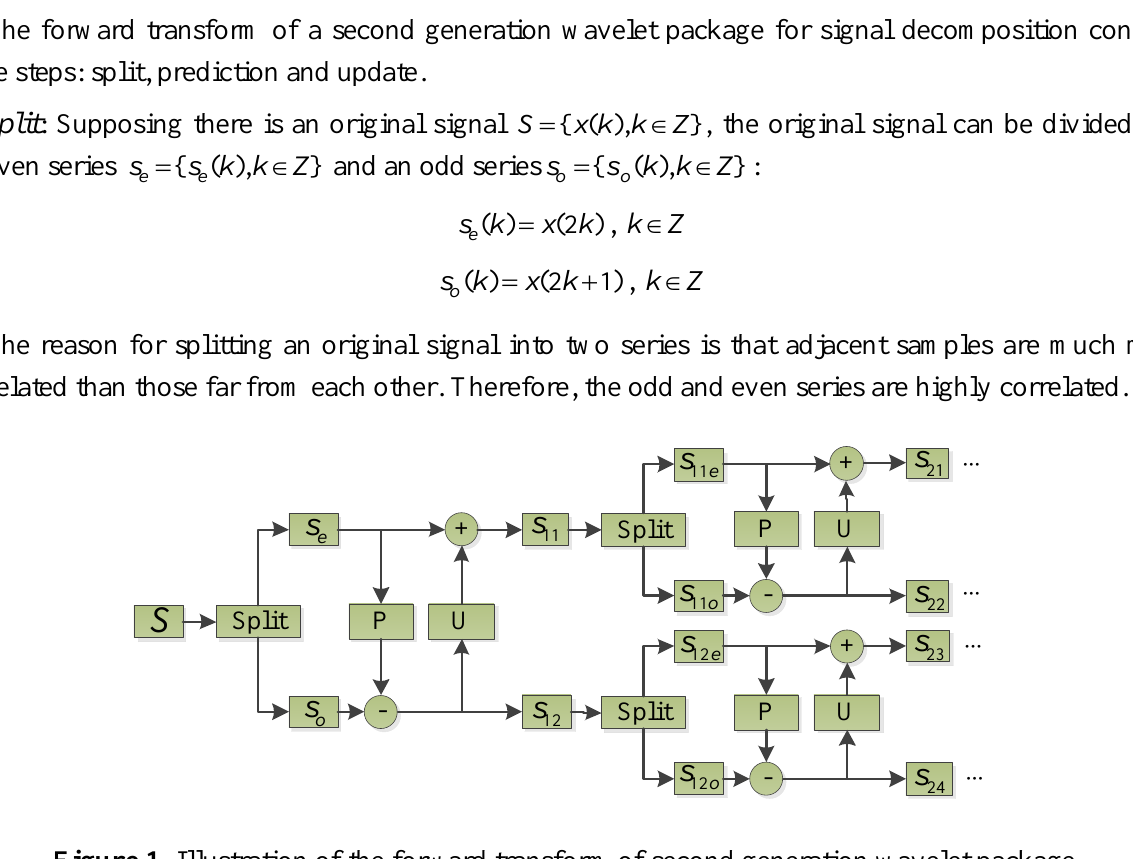
Figure 1. Illustration of the forward transform of second generation wavelet